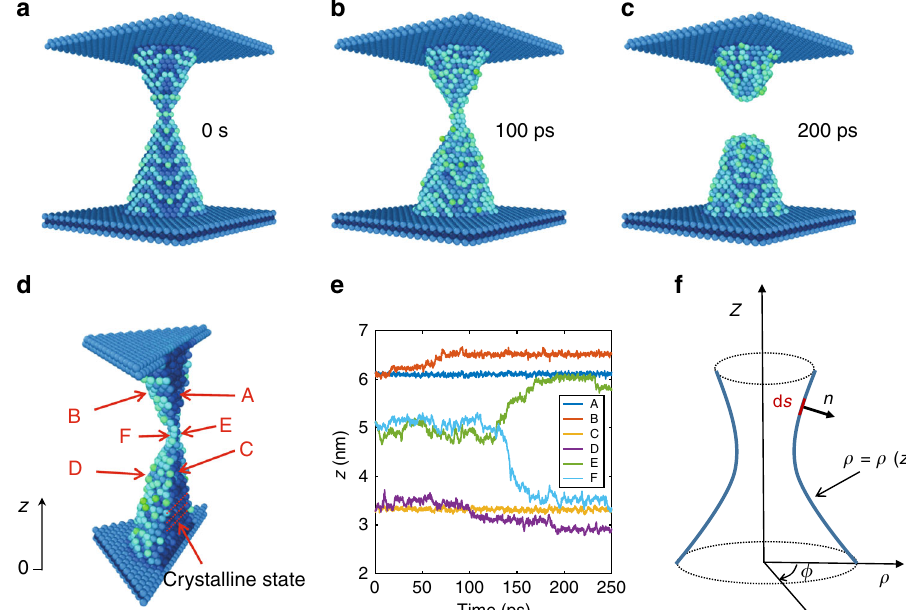
Fig. 2 MD simulation of surface diffusion. a – c MD simulation results of a Ag nanoscale CF between two electrode plates at increasing times, namely t = 0, 100 ps, and 200 ps (Supplementary Movies 1 – 2). The color indicates the free energy per atom with lighter blue representing atoms with higher free energy, hence higher diffusivity. To accelerate the surface diffusion process, the system temperature is set to 800 K, which is still below melting temperature of Ag. d Cross-section view of the CF at 100 ps , indicating stable bulk atoms with low free energy and crystalline states, hence negligible diffusion, whereas surface atoms show higher energy and diffusivity, thus resulting in the morphological evolution and rupture of the fi lament. e Typical traces of individual atoms along z direction for bulk atoms (A, C), surface atoms (B, D), and bottleneck atoms (E, F) in d . Bulk atoms show constant positions, while the surface atoms migrate toward their closest electrodes. Atoms in the CF bottleneck region also show a high tendency to migration to either the top or bottom electrode. (see Supplementary Note 2 and Supplementary Fig. 2 for more analysis). f CF geometry considered in the model of the surface diffusion. For simplicity, isotropic surface diffusion and axisymmetric (along z ) CF surface are assumed. ρ ( z ) de fi nes the geometry of the fi lament surface by rotating around the z axis, and n de fi nes the surface evolution of a surface piece ds in unit time in outward normal